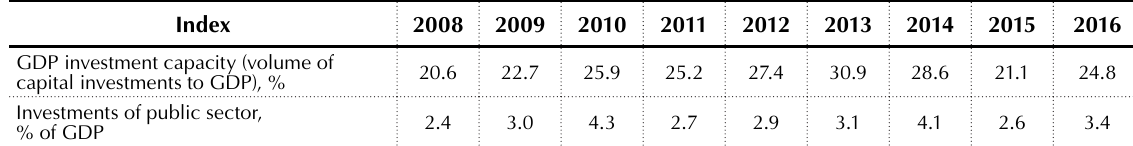
Table 1. Dynamics of changing of GDP investment capacity and a share of state